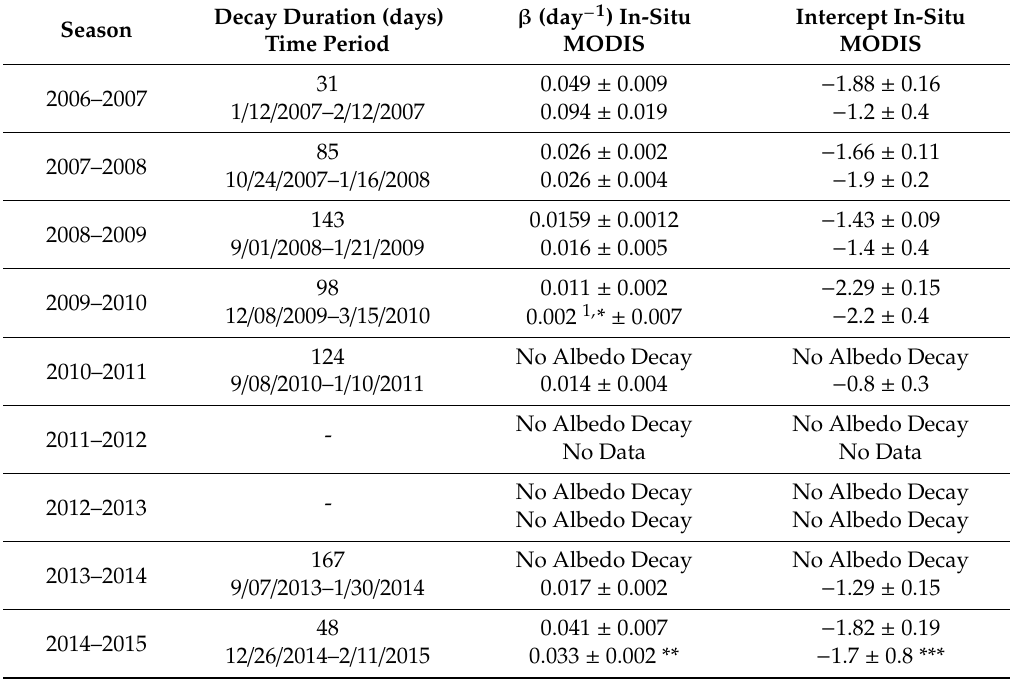
Table 7. Albedo decay characterization for each melting season. Time periods of albedo decay, duration of the periods, decay constant β , and intercept (ln( α (0)– α min )) obtained from the linear fit for in-situ and MOD10A1 albedo data. Dates read as mm / dd / yyyy. For each season, decay constant β and intercept values for in-situ and MOD10A1 albedo data are shown in the upper and lower line,